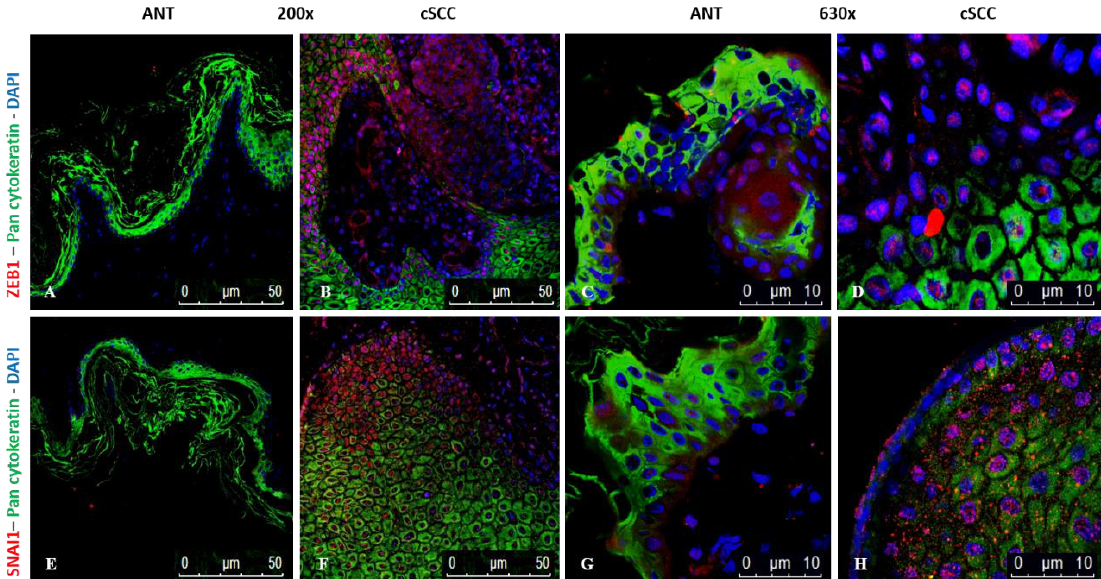
Figure 7. Immunofluorescence showing expression of ZEB1 (red; Panels A – D ) and SNAI1 (red; Panels E – H ) in ANT and cSCC tissues. In all cSCC images (Panels B , D , F , H ), the poorly differentiated cells at the edges of a tumor mass are oriented toward the top and left side of the images with the well-differentiated cells underneath and to the right. Cytokeratin expression (green) was used to delineate well-differentiated epithelial cells in all panels. Blue = DAPI.